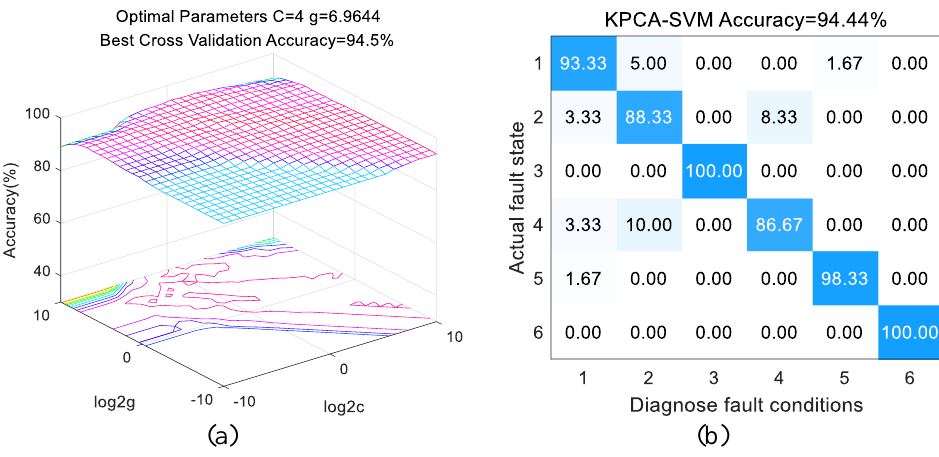
Figure 10. The KPCA dimension reduction method: ( a ) optimal parameters; ( b ) classification re- sults.